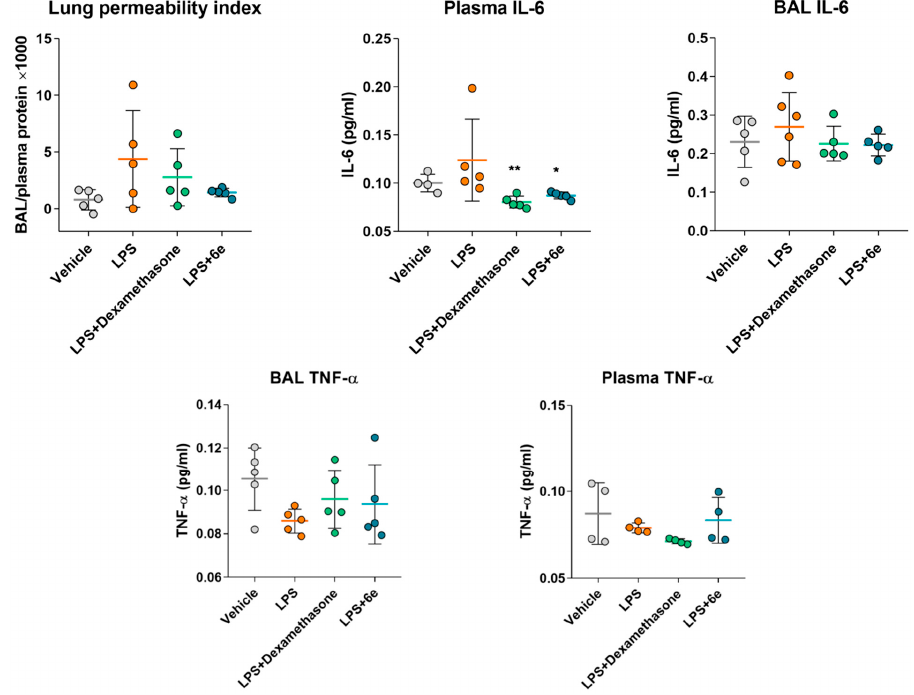
Figure 4. Effect of compounds on biochemical markers of LPS-induced lung injury and inflammation in C57bl/6j mice. Data are shown as mean ± SD; * p < 0.05, ** p < 0.01 (1-way ANOVA with Dunnett’s post-test). BAL—bronchoalveolar